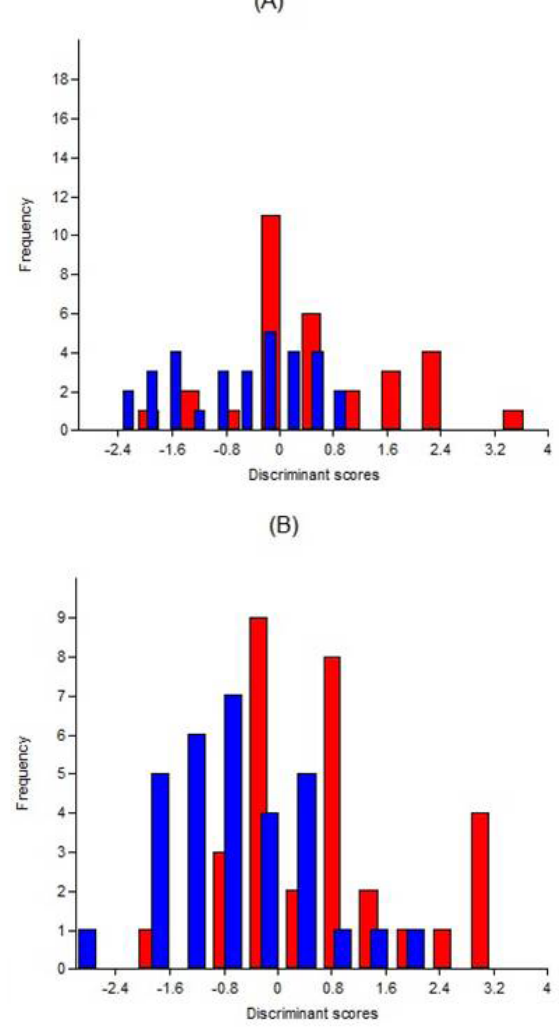
Fig 3 . Frequency of discriminant scores for Corotoca melantho (red) and Constrictotermes cyphergaster (blue) in side view (A) and in top view